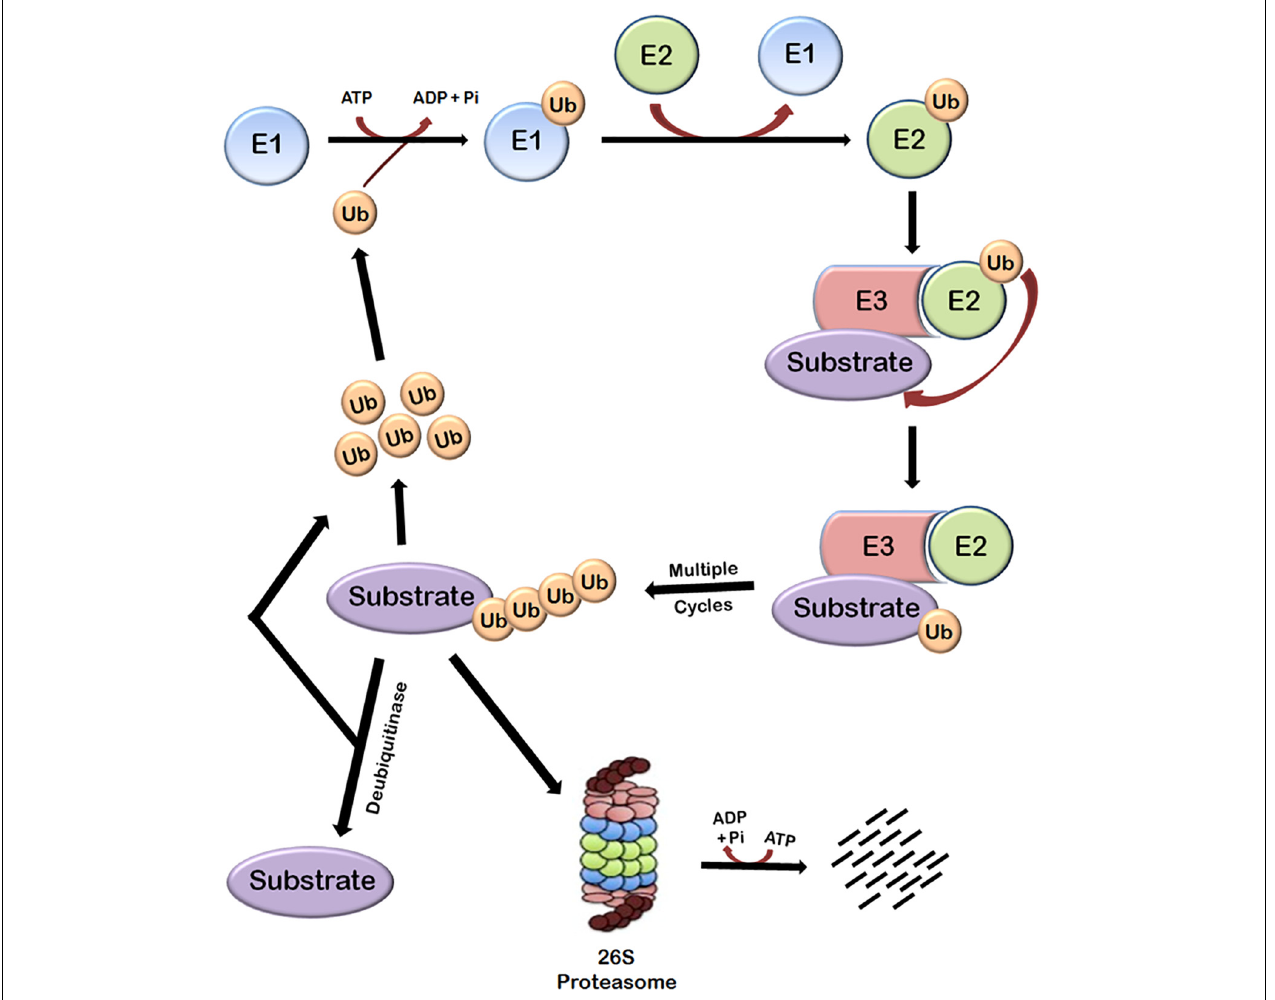
FIGURE 1 | Ubiquitin-dependent proteasomal degradation pathway. The cellular proteins are targeted to ubiquitin-dependent degradation by a set of three enzymes. E1 first binds to ubiquitin molecule and transfers it to E2. E2 interacts with substrate bund E3 and ubiquitin is transferred to the substrate. Repeated actions of these three enzymes cause polyubiquitination of the substrate followed by its degradation by proteasome and release of free ubiquitin molecules which can again bind with E1 to initiate the ubiquitination of another substrate. This process requires energy which is obtained from the hydrolysis of ATP. Polyubiquitinated substrates can also be deubiquitinated by another class of enzymes called deubiquitinases, which results in the release of free substrate molecules.